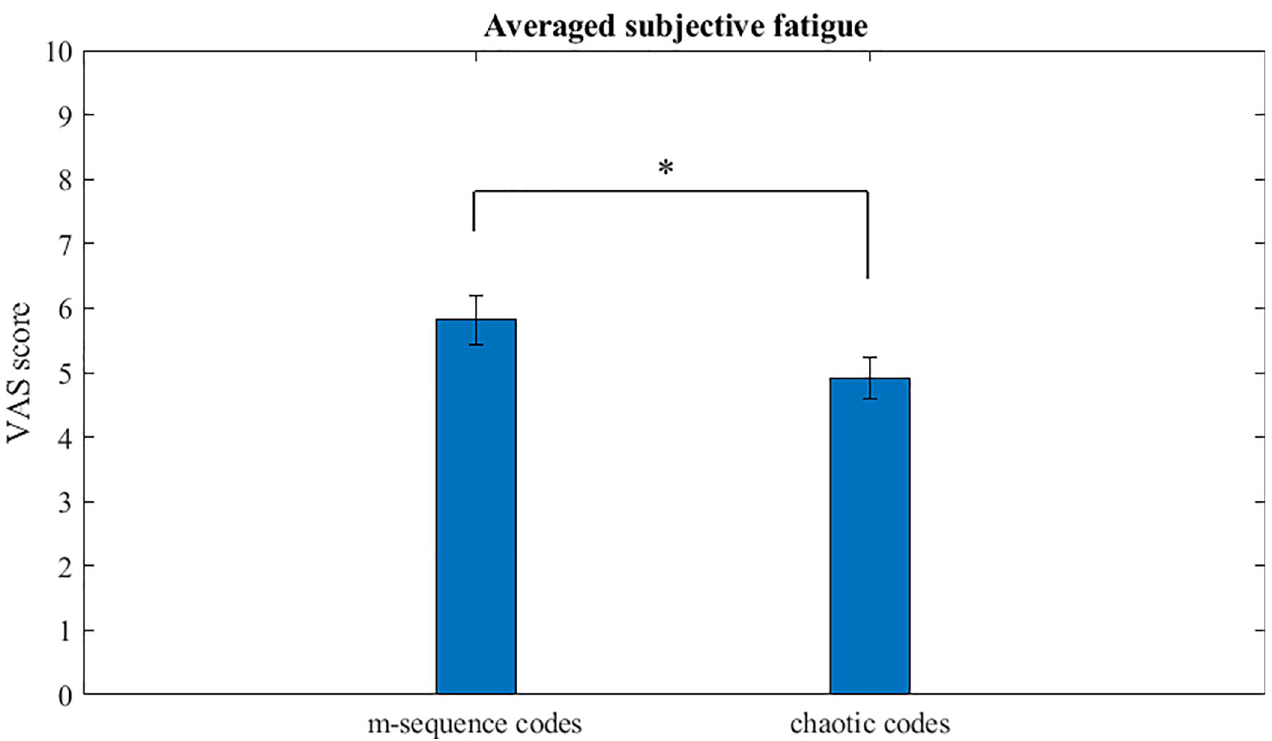
Fig 15. Averaged subjective fatigue scores of all m-sequence and chaotic codes of all the subjects. The chaotic codes VAS score was significantly lower than the m-sequence codes, � p = 0.0005, n = 44.